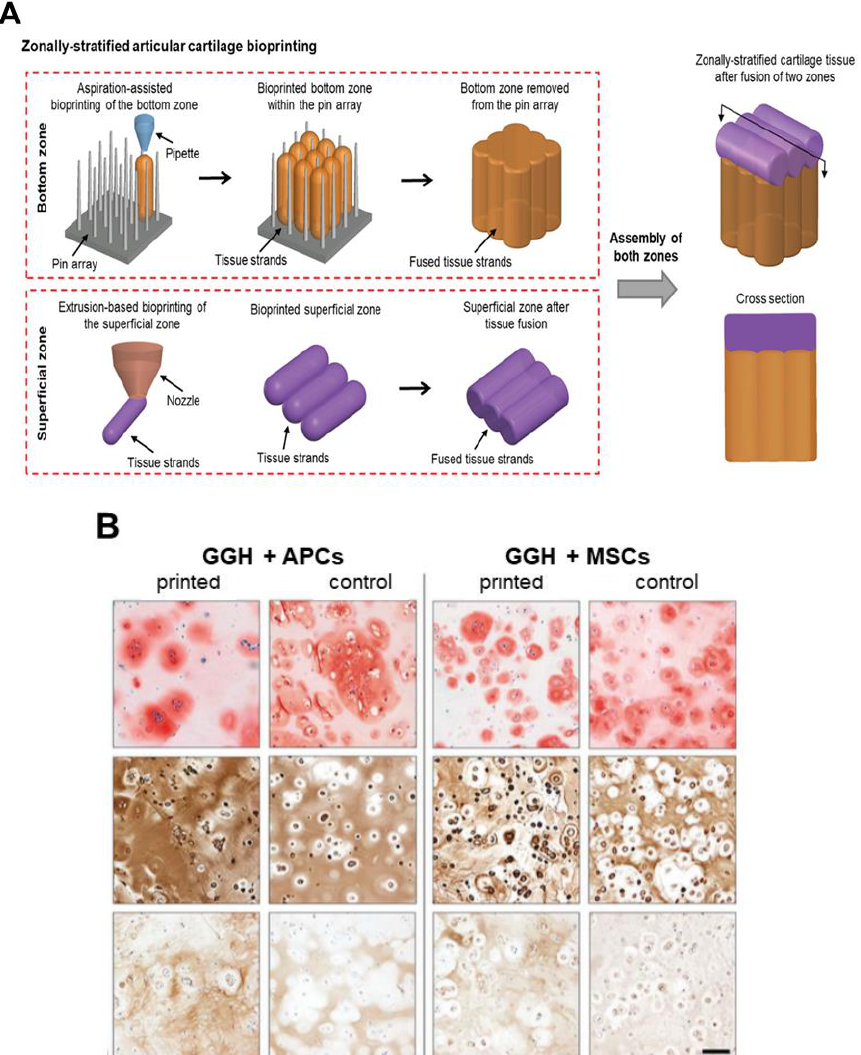
Figure 10. Layered scaffolds: ( A ) Schematic image of the manufacture of zonally stratified articular cartilage. Adapted from [71]. ( B ). Histological images of GAGs (safranin-O, top ), collagen type II ( middle ), and collagen type I ( bottom ) matrix of APCs and MSCs in GelMA/gellan gum/HAMA (GGH) bioprinted scaffolds at day 42. Scale bar = 100 μm. Adapted from [72].